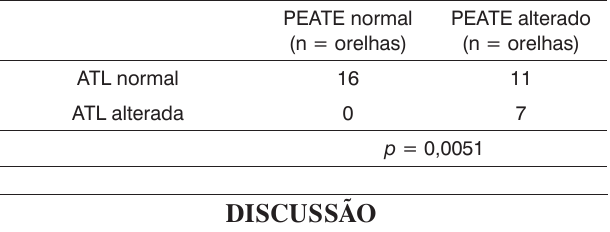
Tabela 8. Comparação entre os resultados da audiometria tonal liminar e dos potenciais evocados auditivos de tronco